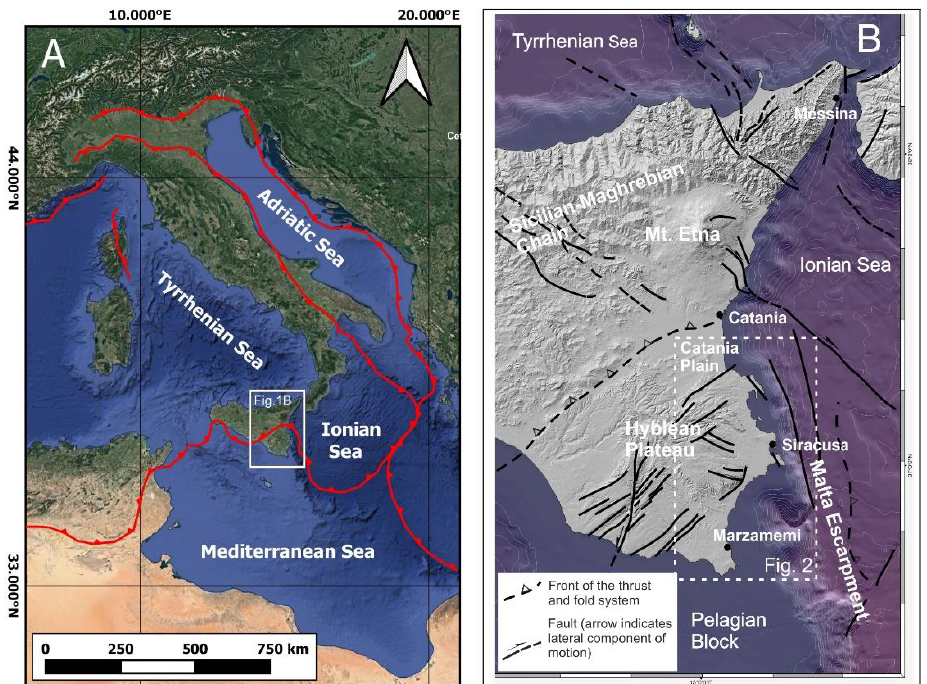
Figure 1. Tectonic and kinematic sketch of the Sicily–Calabria region. ( A ) The white rectangle is the investigated area in this study (basemap by Google Satellite). The thick red lines show seismic belts not clearly associated with well constrained fault systems. ( B ) Instrumental seismicity [27] and the Italian Seismic Instrumental and parametric Database have been considered (ISIDE; available at http://iside.rm.ingv.it (accessed on 6 January 2021) [28]).